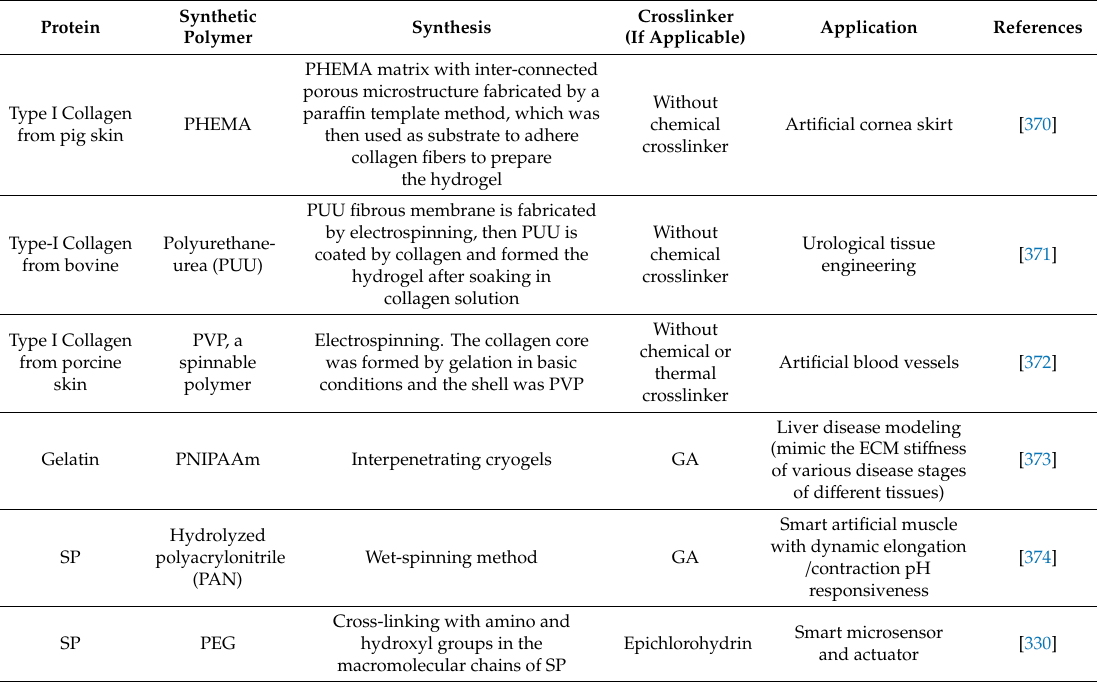
Table 5. Recent developments in biomedical applications of protein based hybrid